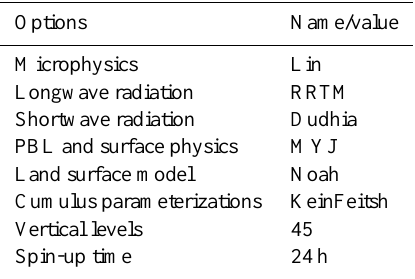
Table 2. Different physics and model options used in the control